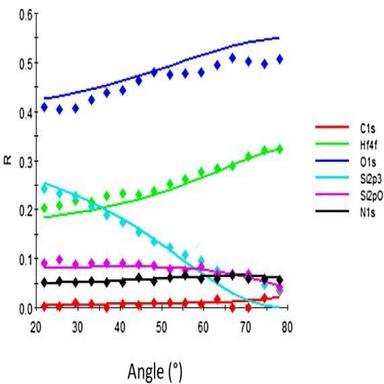
a. Normalized a.u. % ages as a function of angle for HfO2 /Chem-Ox IL (5A) after DPN; Fig. 4c. Depth profile result of Max Ent simulation of the data in Fig. 4a; Fig. 4b and d, as 4a and 4c, but for an equivalent wafer after PNA at 700C.